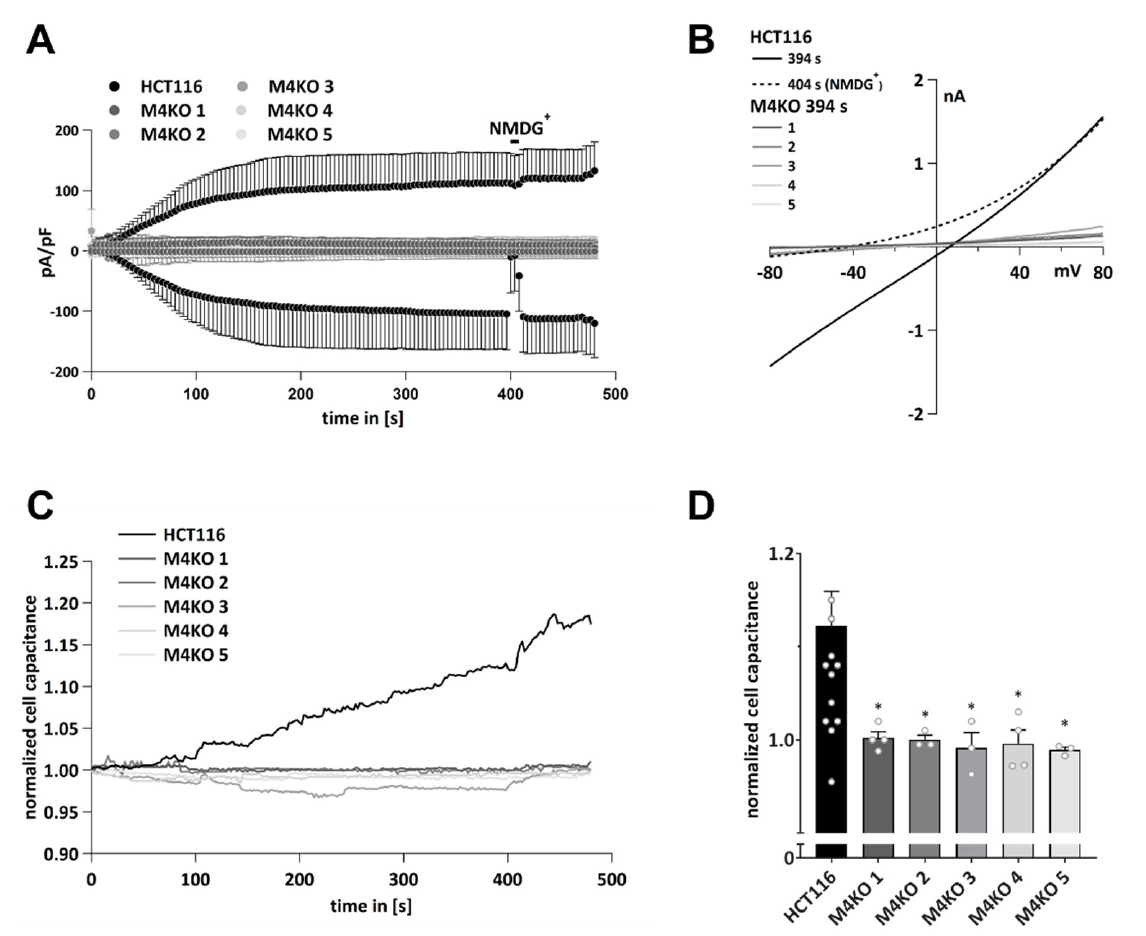
Figure 1. Patch clamp analysis and analysis of cell capacitance changes in HCT116 and M4KO clones. ( A ) I CAN was evoked with 10 μ M Ca 2+ in the pipette ( n = 14 for HCT116, n = 4 for M4KO 1, n = 3 for M4KO 2, n = 3 for M4KO 3, n = 3 for M4KO 4, and n = 3 for M4KO 5). ( B ) Corresponding averaged IVs at 394 s and 404 s (before and during application of NMDG + ) from cells in (A). ( C ) Detected changes in cell capacitance in HCT116 and M4KO cell lines after activation with 10 μ M Ca 2+ . The cell capacitance was normalized to the first point of each measurement and plotted versus time ( n = 14 for HCT116, n = 4 for M4KO 1, n = 3 for M4KO 2, n = 3 for M4KO 3, n = 3 for M4KO 4, and n = 3 for M4KO 5). ( D ) Scatter plot and bar diagram of data in ( C ) at 394 s, shown as mean + SD. Mann–Whitney test for non-parametric data was used to determine statistical significance (* p < 0.05).